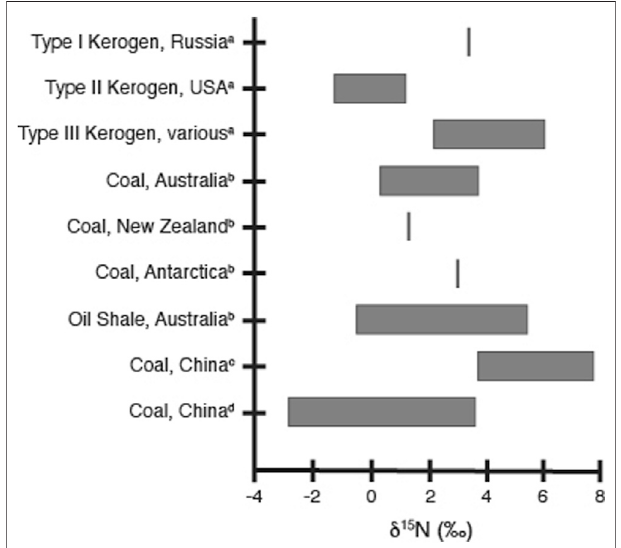
FIGURE 2 | Ranges of measured δ 15 N values for selected kerogen and coal samples, as referred to in the text. Values shown are from a Boudou et al. 2008 and references therein, b Rigby and Batts 1986, c Xie et al. 2021 and references therein, and d Ding et al. 2018; for analytical and sample details, please refer to the original